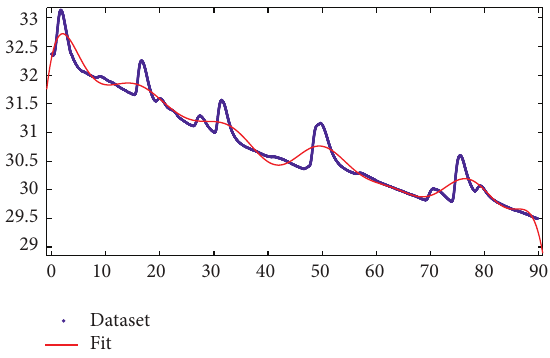
Figure 8: An SC signal processed in real time with a Fit function, based on a sum of sinusoids ( 𝑓(𝑥) = 𝑎1 ∗ sin (𝑏1 ∗ 𝑥 + 𝑐1) + 𝑎2 ∗ sin (𝑏2 ∗ 𝑥 + 𝑐2) + 𝑎3 ∗ sin (𝑏3 ∗ 𝑥 + 𝑐3) + 𝑎4 ∗ sin (𝑏4 ∗ 𝑥 + 𝑐4) + 𝑎5∗ sin (𝑏5∗𝑥+𝑐5) + 𝑎6∗ sin (𝑏6∗𝑥+𝑐6) + 𝑎7∗ sin (𝑏7∗𝑥+𝑐7) + 𝑎8 ∗ sin (𝑏8 ∗ 𝑥 + 𝑐8) .). Horizontal axis represents time (in seconds) and vertical axis represents the SC level (in microsiemens ( 𝜇